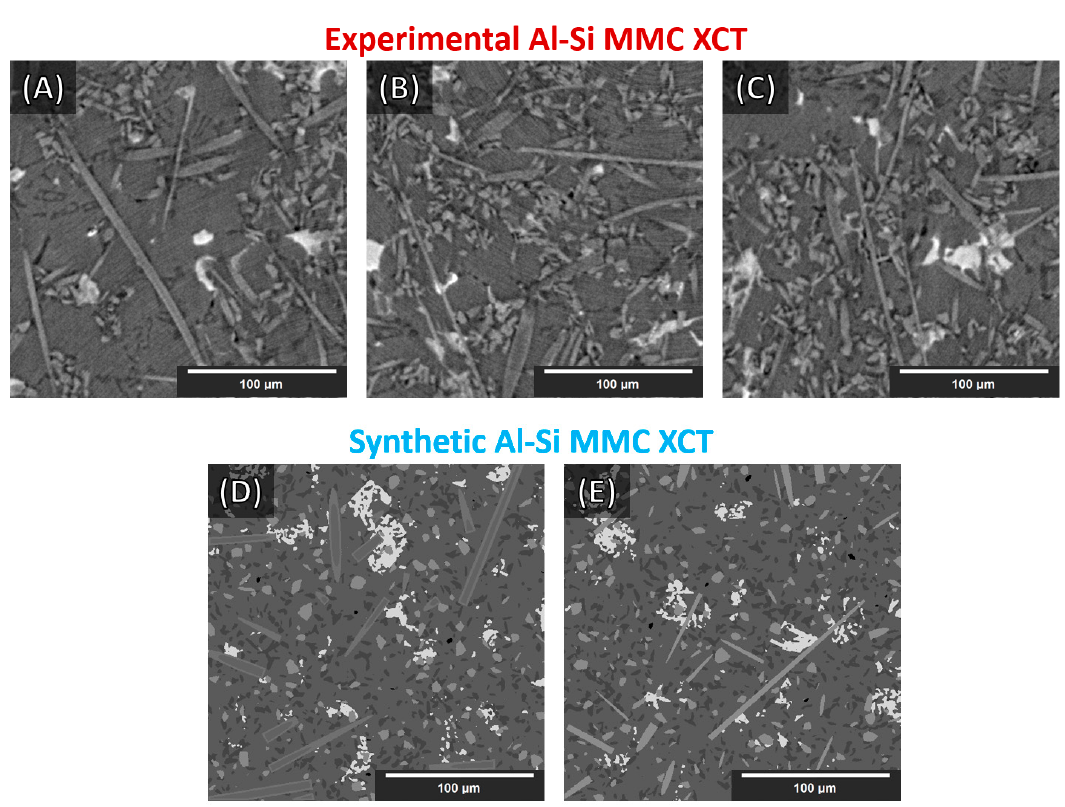
Figure 3. Synthetic Al–Si MMC generation procedure flowchart.